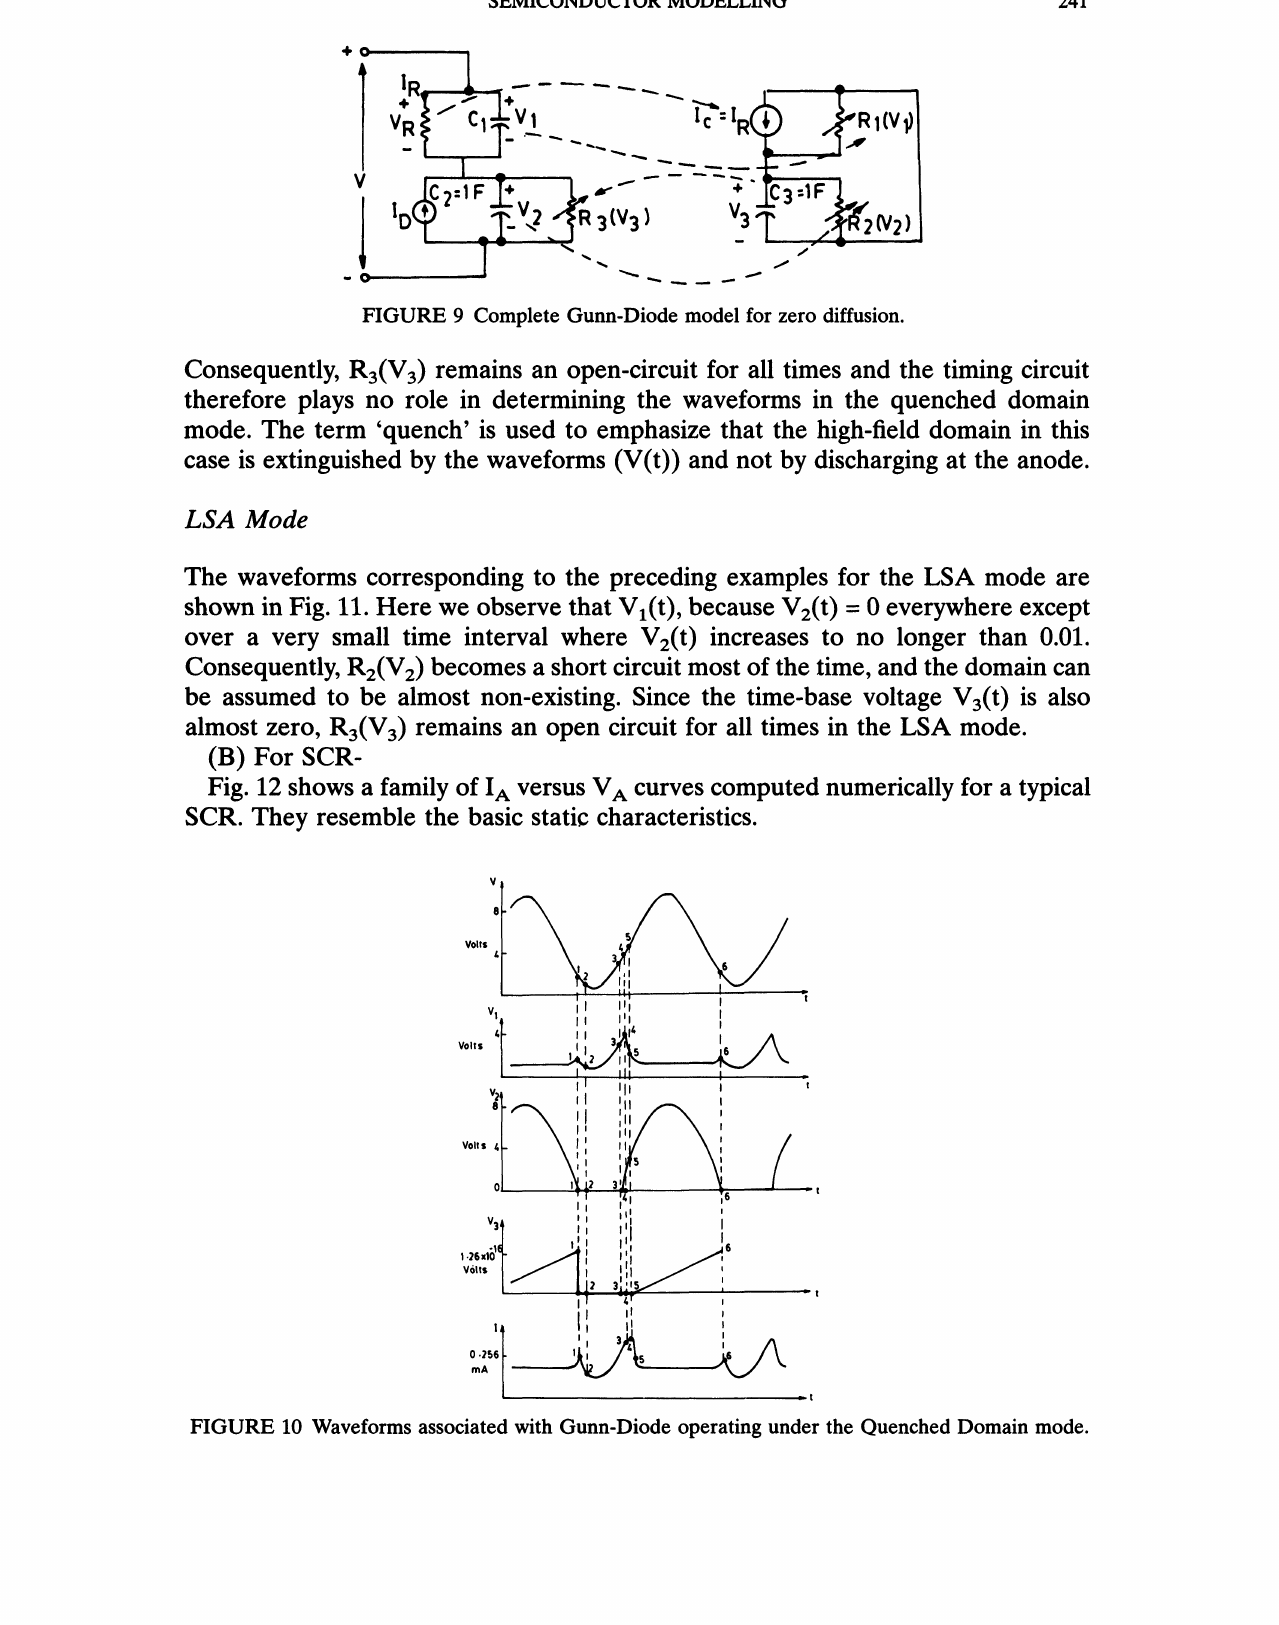
FIGURE 9 Complete Gunn-Diode model for zero diffusion.